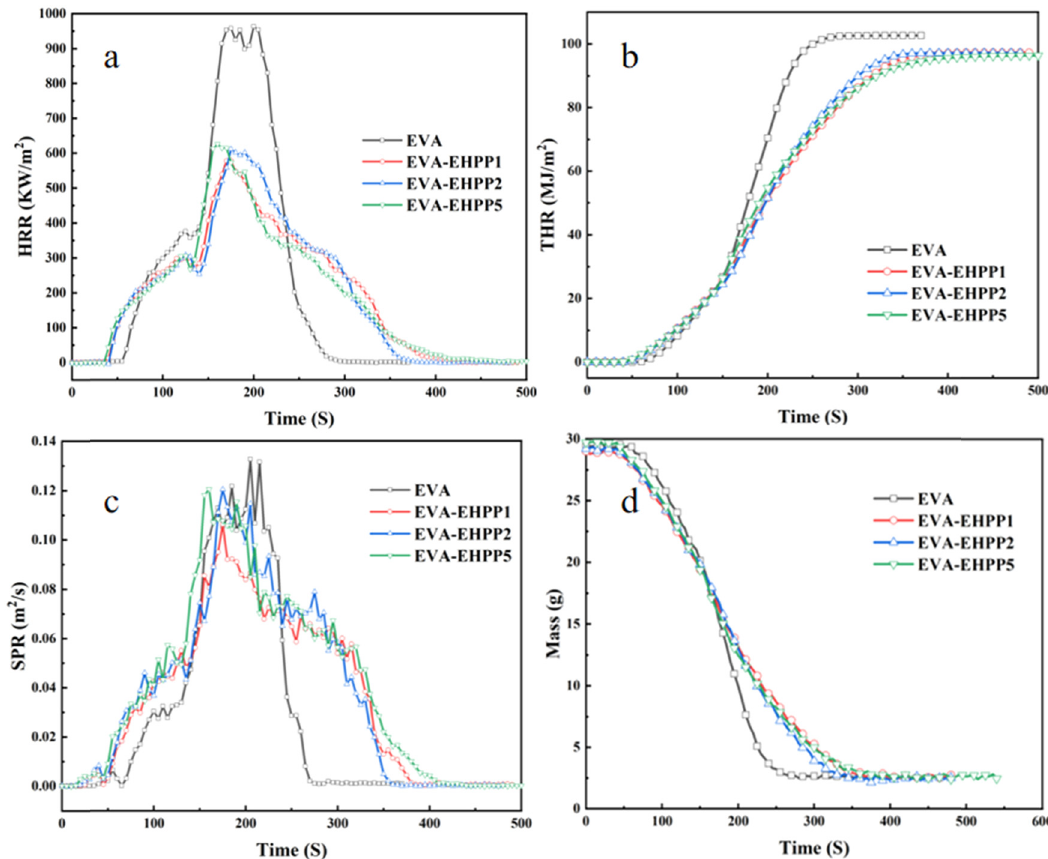
Figure 5: HHR ( a ) , THR ( b ) , SPR ( c ) , and mass loss ( d ) curves of EVA and its composites.